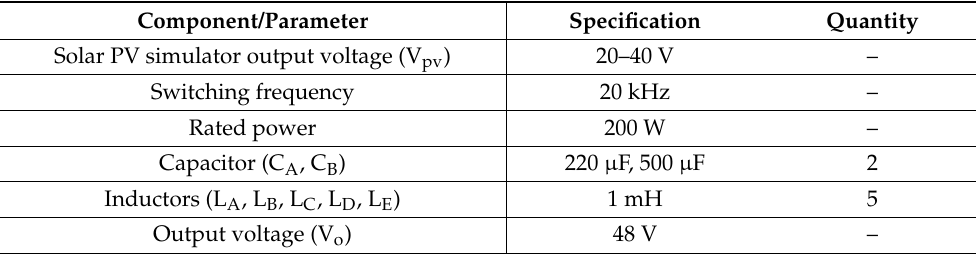
Figure 4. Operation of the proposed IIABB converter with an intelligent control strategy: ( a ) the power MOSFET S A is ON and the power MOSFETs S B , S C , and S D are OFF, ( b ) the power MOSFET S B is ON and the power MOSFETs S A , S C , and S D are OFF, ( c ) the power MOSFET SC is ON and the power MOSFETs S A , S B , and S D are OFF, and ( d ) the power MOSFET S D is ON and the power MOSFETs S A , S B , and S C are OFF. Table 1. The parameters of the proposed IIABB